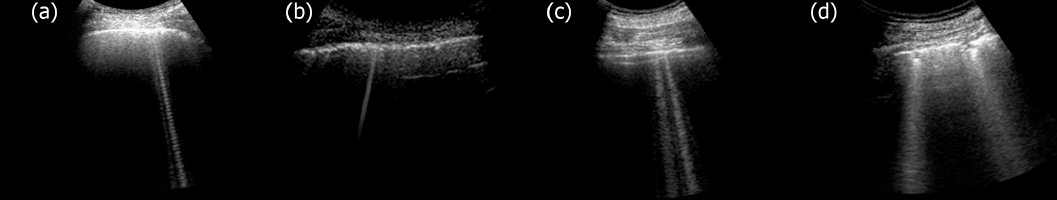
Figure 4. Lung US images acquired with a Toshiba Aplio XV scanner and a PVT-375BT convex probe are shown. From left to right, ( a ) a modulated acoustic sign, ( b ) an acoustic sign with a uniform gray level, ( c ) slight confused acoustic signs, and ( d ) confused acoustic signs starting beyond the pleura line are shown, respectively.